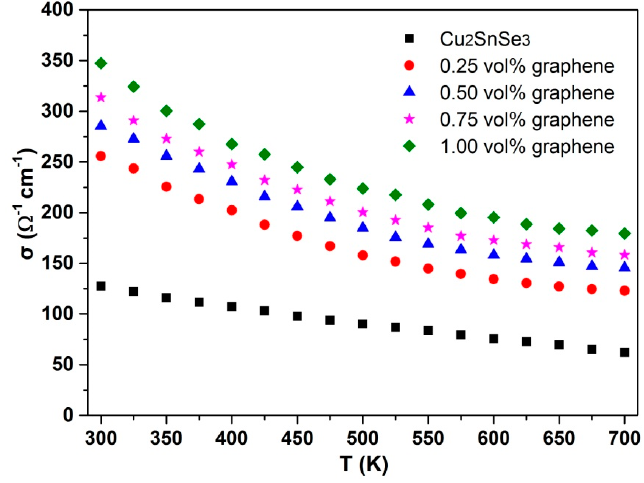
Figure 8. Electrical conductivity of graphene/Cu 2 SnSe 3 samples as a function of temperature. Table 1. Chemical composition and some physical and structural parameters of graphene/Cu 2 SnSe 3 composites at room